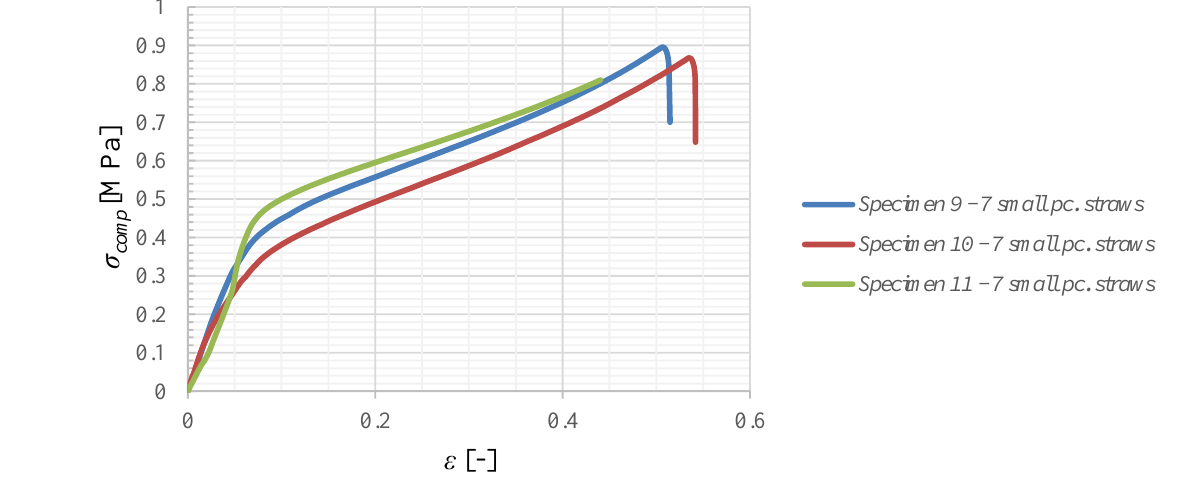
Figure 11. Measured results for polystyrene reinforced with small straws.